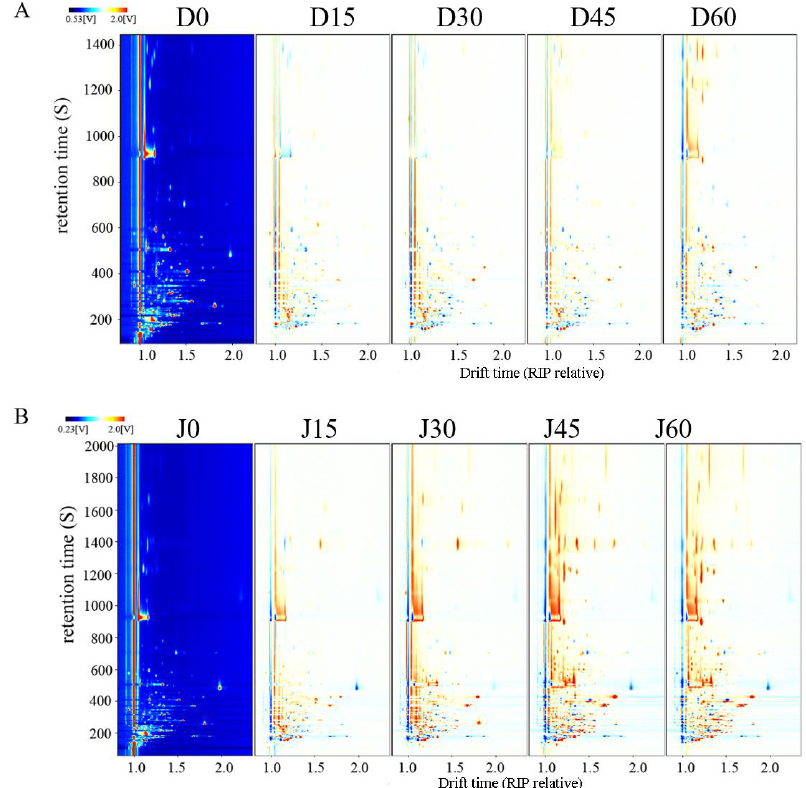
Figure 3. 2D-topographic plots of jujube fruits at different times. Jujube fruits are Dongzao shown in ( A ), D0, D15, D30, D45, and D60 represent refrigeration for 0, 15, 30, 45, and 60 days, respectively. Jujube fruits are Jinsixiaozao shown in ( B ), J0, J15, J30, J45, and J60 represent refrigeration for 0, 15, 30, 45, and 60 days, respectively.